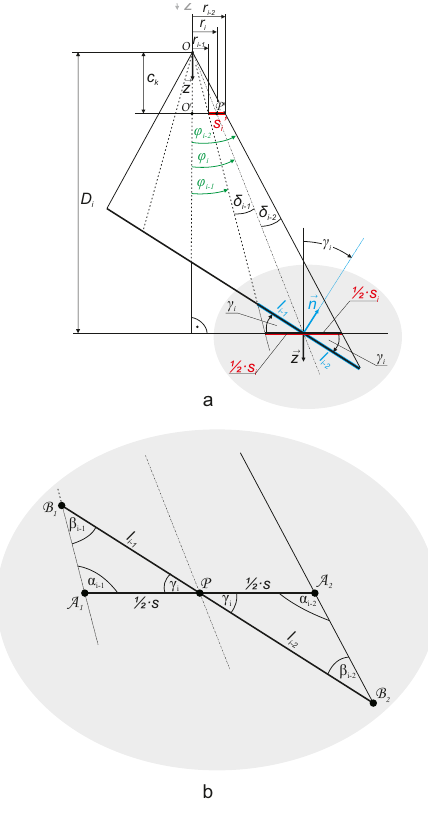
Figure 2: Detailed geometry for calculations of the resolution If the distance D i , which is the distance from the projection cen- ter to the photographed surface is known, the resolution of this parallel surface can be easily calculated using (1) by replacing H with D i , which results in c k